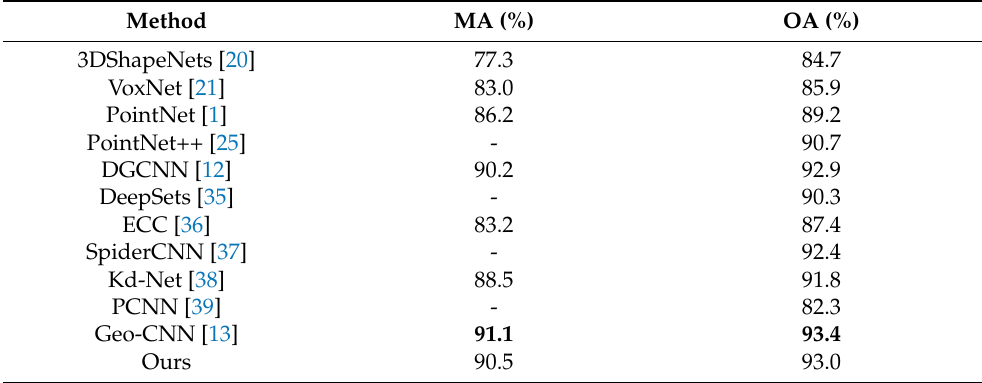
Table 2. Classification accuracy on ModelNet40.